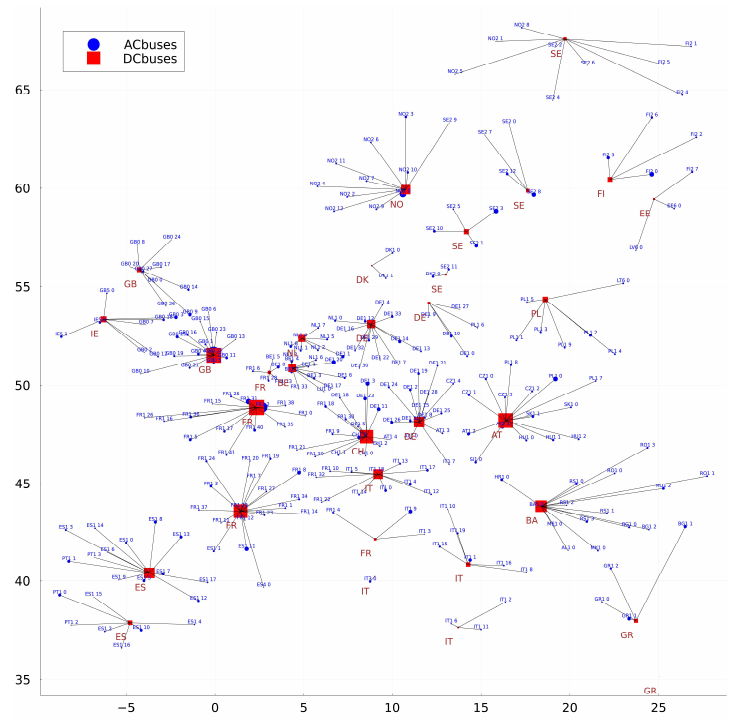
Figure 2. Allocation results.